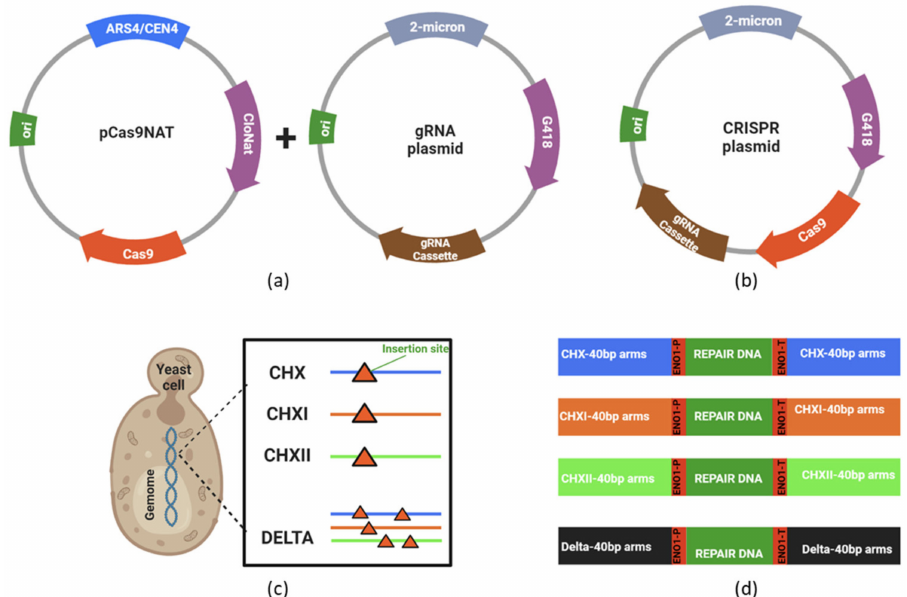
Figure 1. A schematic overview of the CRISPR-Cas9 systems used to transform a diploid industrial and a haploid laboratory S. cerevisiae strain. ( a ) Schematic illustration of the two-plasmid CRISPR system. A low-copy replicative (CEN/ARS-containing) plasmid contained the cas9 gene and the se- lection marker for CloNAT resistance, and a multi-copy plasmid (2 µ ) contained the gRNA expression cassette and the selection marker for G418 resistance. ( b ) Schematic illustration of the one-plasmid CRISPR system. A multi-copy (2 µ ) plasmid contained the cas9 gene, a gRNA cassette, and a selection marker for G418 resistance. ( c ) The CRISPR system targeted chromosomal intergenic sites for the integration of different genomic repair expression cassettes for gene editing. “Delta” represents the repeated Ty delta elements dispersed in the yeast genome that allows multi-target integration. Delta sequences are referred to by the symbol ∆ elsewhere. ( d ) The repair DNA cassettes contained reporter genes flanked by the ENO1 promoter, ENO1 terminator, and 40-bp homology arms, targeting integration to the various genomic